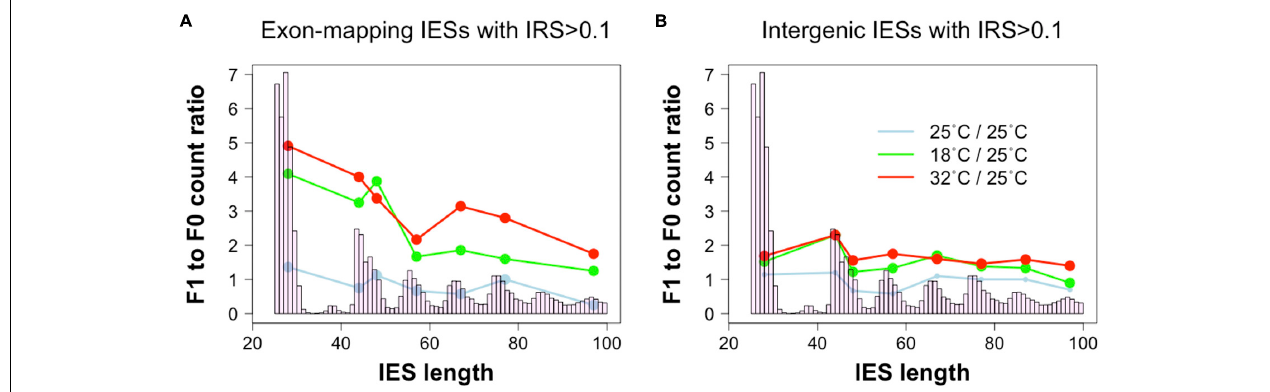
FIGURE 3 | Ratio of incomplete IES excision (IRS > 0.1) counts in parental and filial generations. The two consecutive generations are exposed to either a stable environment in which both F0 and F1 were cultivated at 25 ◦ C (light blue) or a changing environment in which the F0 was cultivated at 25 ◦ C, but the F1 was cultivated either at 18 ◦ C (green) or 32 ◦ C (red). Grouping IESs according to genomic location (coding exons, intergenic) reveals that small exon-mapping IESs are more often incompletely excised compared to larger exon-mapping IESs (A) . No size-dependent pattern is detected for intergenic IESs (B) . Ratios were calculated after summing incompletely excised IESs falling in the most frequent size classes (bp): 26–30, 44–45, 46–50, 54–60, 64–70, 74–80, 84–90, and 94–100. Only size classes with ≥ 3 incompletely excised IESs per condition were examined.